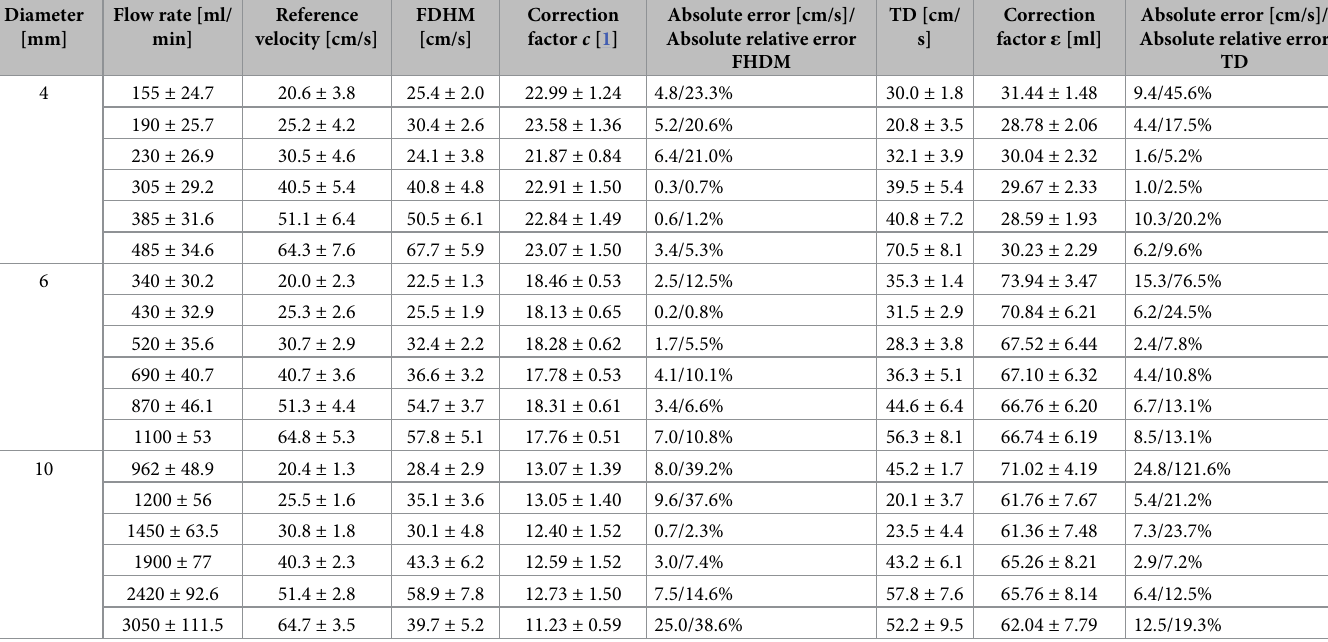
Table 1. MPI-derived velocities in non-stenotic phantoms.